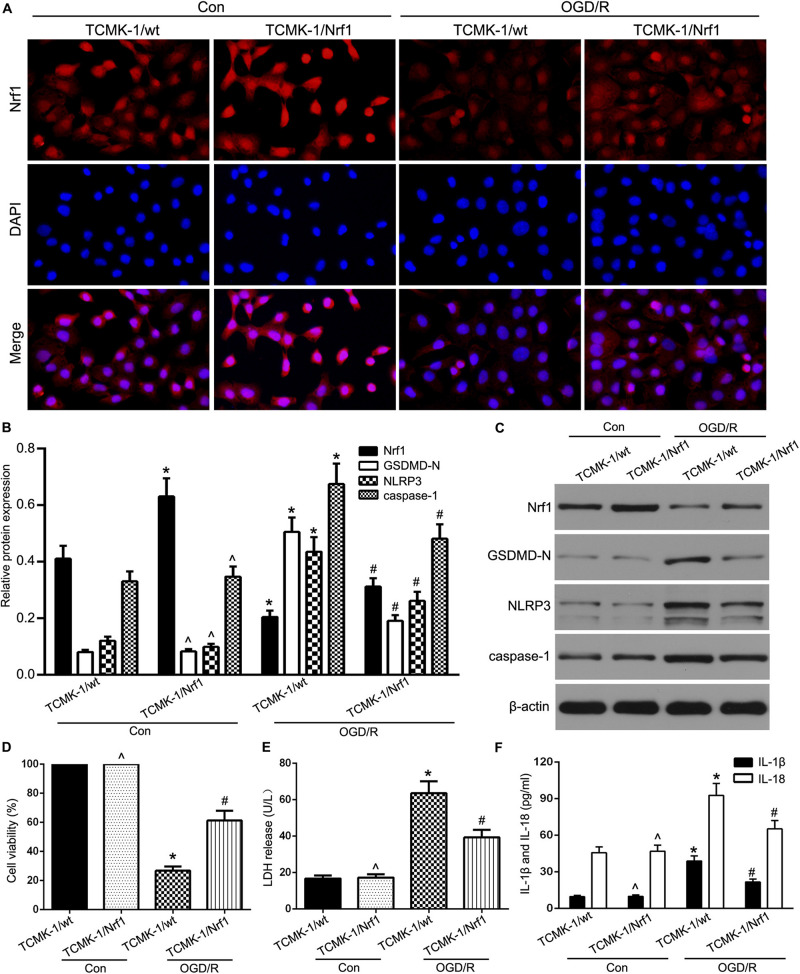
Nrf1 overexpression alleviated TEC pyroptosis in OGD/R-stimulated TCMK-1 cells. (A) Representative photomicrographs of Nrf1 expression in TCMK-1 cells by immunofluorescence, 400×, scale bar = 20 μm. (B,C) Western blot analysis of Nrf1, GSDMD-N, NLRP3, and caspase-1 expression in TCMK-1 cells. (D) Cell viability was detected by CCK-8 assay. (E) The LDH release was detected by activity assays. (F) IL-1β and IL-18 contents were measured by using ELISA kits. Data are expressed as the mean ± SD. n = 3 per group. *P < 0.05 vs. TCMK-1/wt con group, ∧P > 0.05 vs. TCMK-1/wt con group, #P < 0.05 vs. OGD/R-induced TCMK-1/wt group, one-way ANOVA.